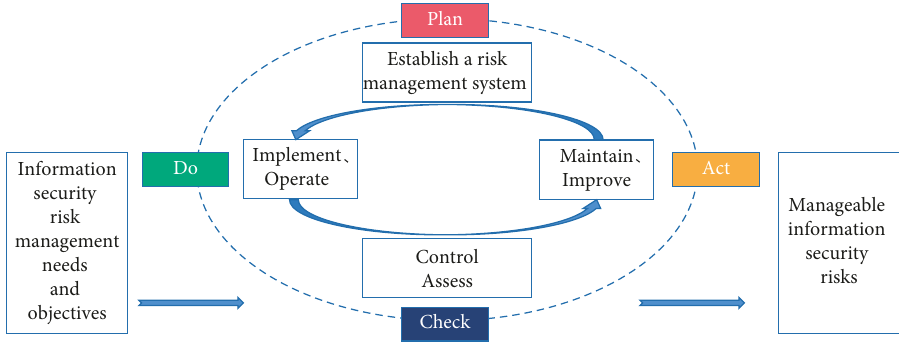
Figure 2: PDCA model.